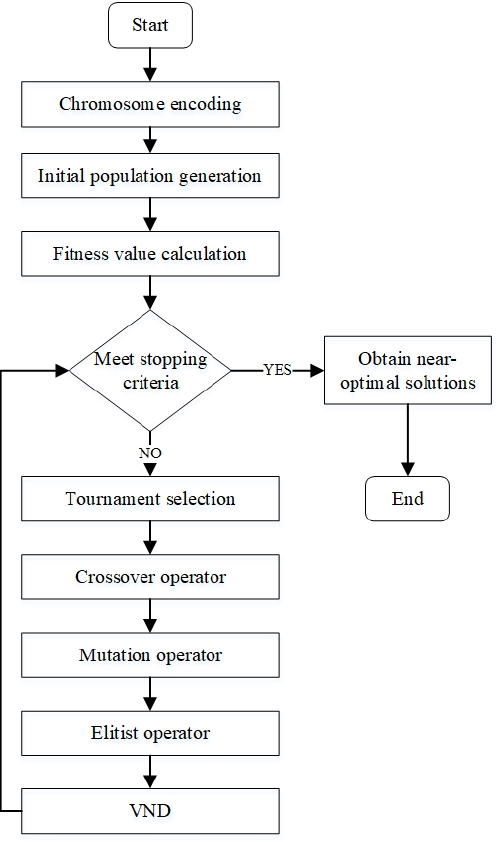
Figure 2. The flowchart of the hybrid GAVND heuristic.